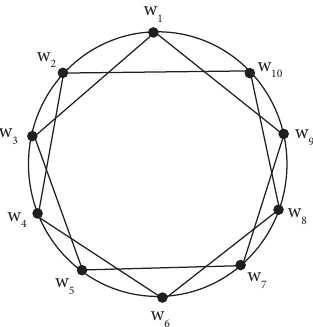
Figure 4: Te graph of C 2